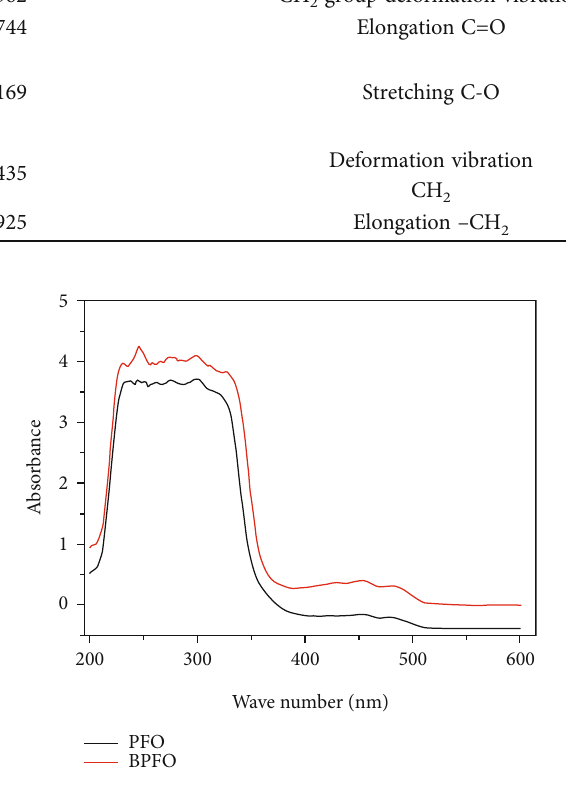
Figure 8: Superimposed UV-VIS spectra of Podocarpus falcatus oil (PFO) and it biodiesel